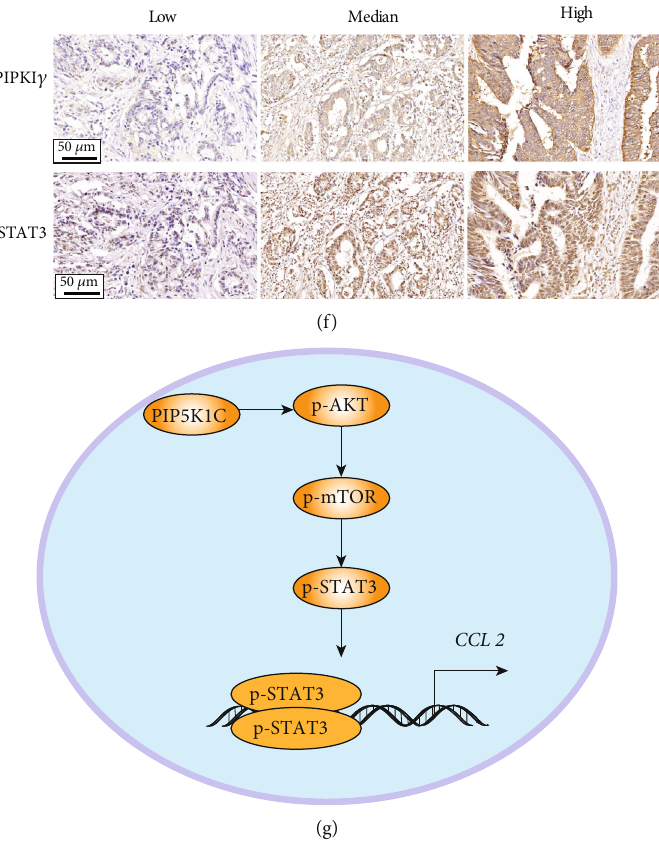
Figure 4: AKT activation by PIPKI γ mediated STAT3 phosphorylation and CCL2 expression in CRC. (a) q-PCR analysis of CCL2 mRNA levels in HCT116 and SW620 cells overexpressing PIPKI γ or not and treated with the AKT inhibitor ADZ5363 or the mTOR inhibitor rapamycin. (b) ELISA analysis of CCL2 protein levels in HCT116 and SW480 cells overexpressing PIPKI γ or not and treated with the AKT inhibitor ADZ5363 or the mTOR inhibitor rapamycin in FBS-free medium. (c) Western blot analysis of the phosphorylation